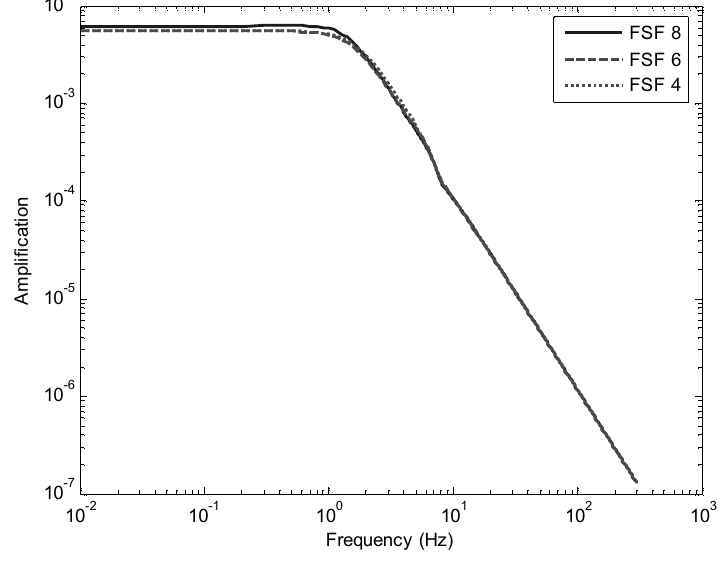
Fig. 7. Roll angle for lateral acceleration input.